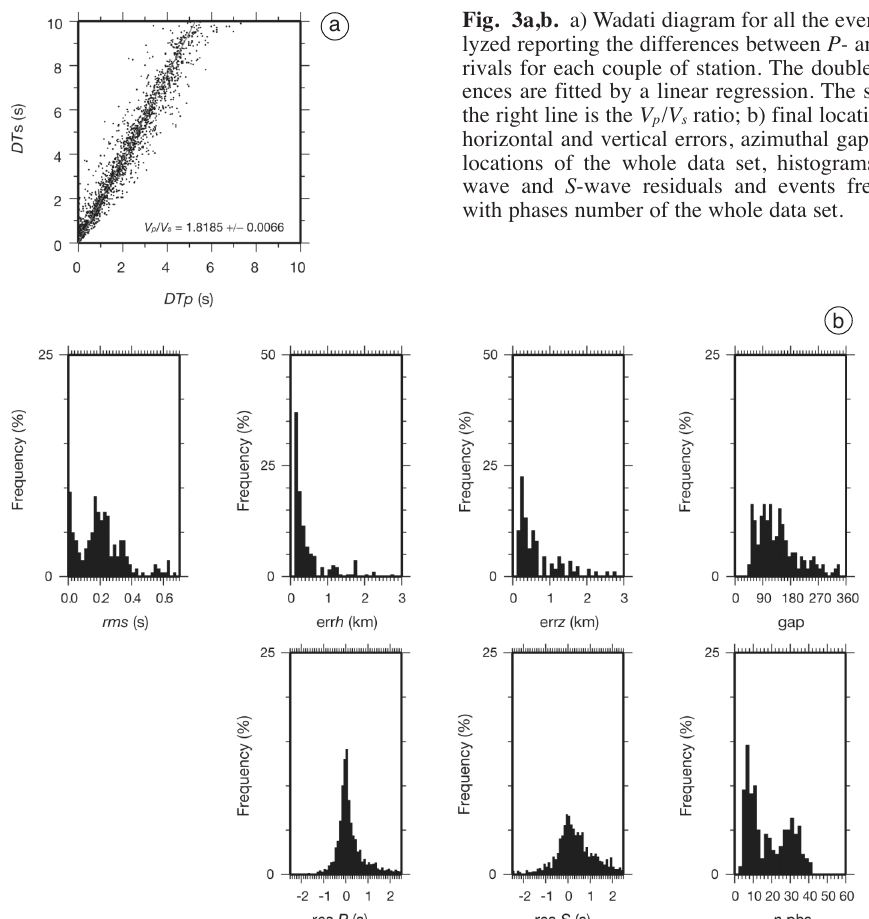
Fig. 3a,b. a) Wadati diagram for all the events ana- lyzed reporting the differences between P- and S -ar- rivals for each couple of station. The double differ- ences are fitted by a linear regression. The slope of the right line is the V p / V s ratio; b) final location rms, horizontal and vertical errors, azimuthal gap for the locations of the whole data set, histograms of P - wave and S -wave residuals and events frequency with phases number of the whole data set.